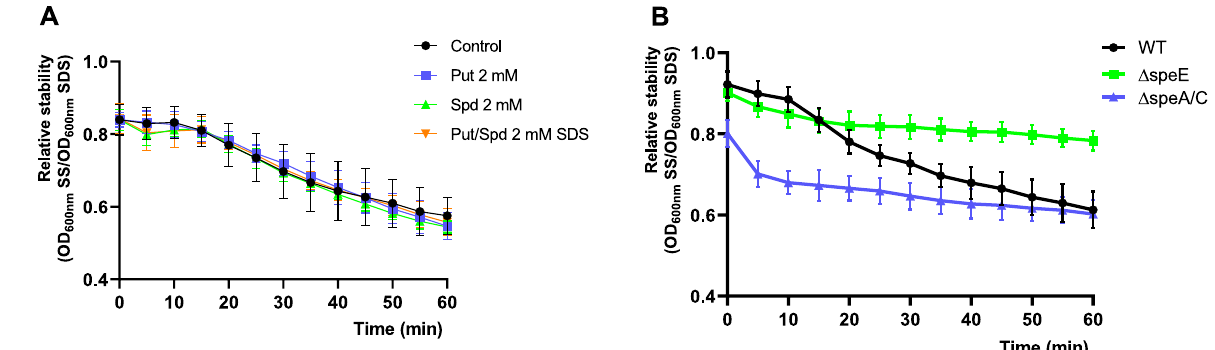
Figure 6. Effects of polyamines on the stability of the outer membrane. ( A ) Cells were incubated in Put or Spd alone or in combination for 1 h before incubation in saline solution (SS) or 0.1% SDS (SDS), and the OD 600 of the culture recorded during 60 min. Membrane stability is expressed as the absorbance in SDS relative to that in SS. ( B ) wild type and mutant strains were analyzed following the same approach as in ( A ).